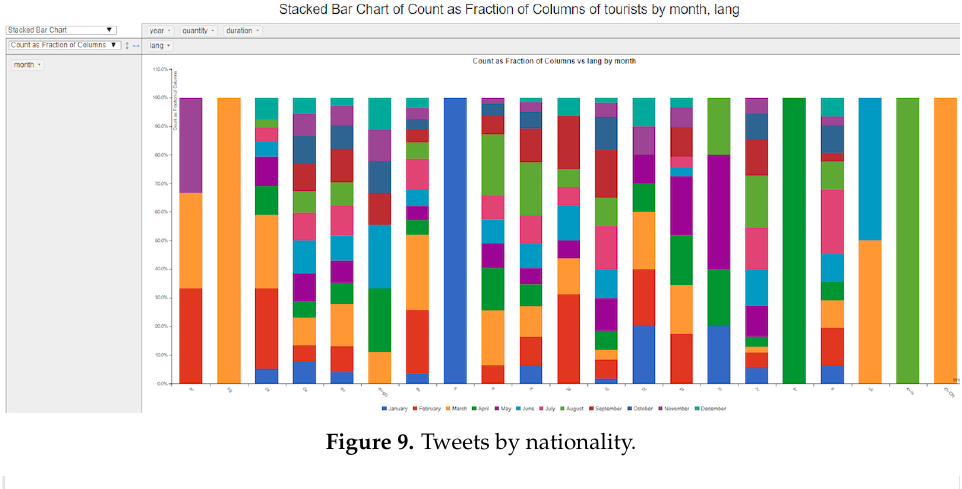
Figure 8. Stay duration grouping tourists by language.